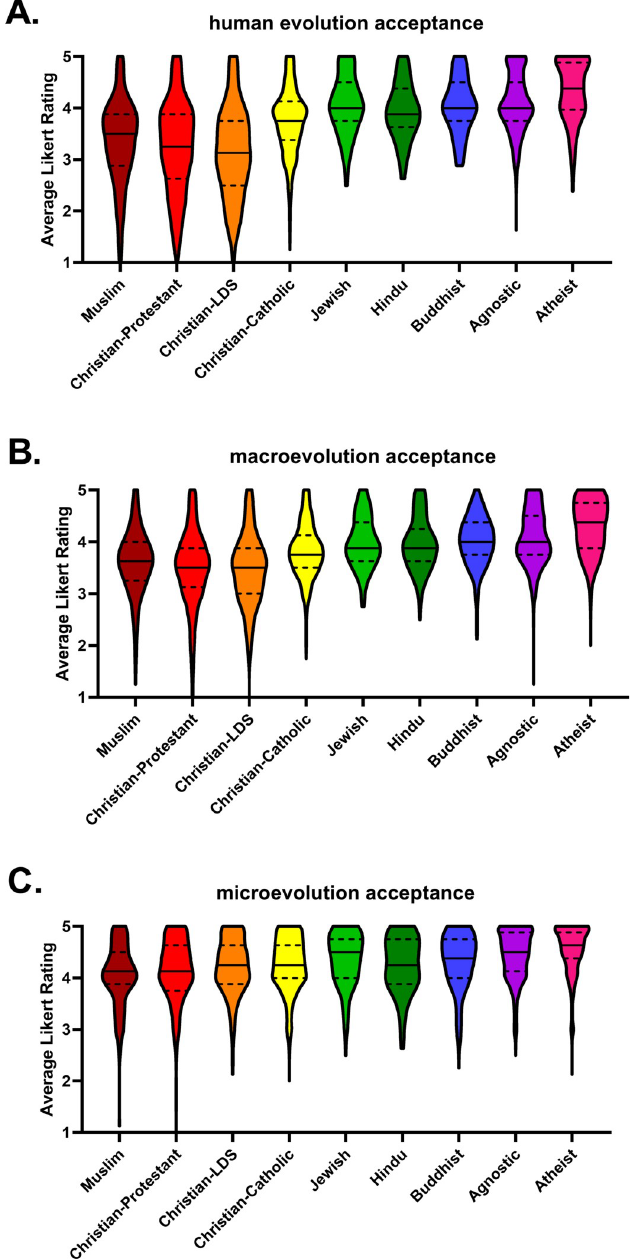
Fig 3. Acceptance of evolution. Violin plots of students’ (A) human evolution acceptance scores, (B) macroevolution acceptance scores and (C) microevolution acceptance scores disaggregated by religious affiliation. The violin shapes are the densities of the data at each point on the y-axis. The solid black lines are the medians, and the top and bottom broken lines are the 75 th and 25 th percentiles of the data. When there is not line for the median or 25 th percentile this means those values overlap with the minimum value of the